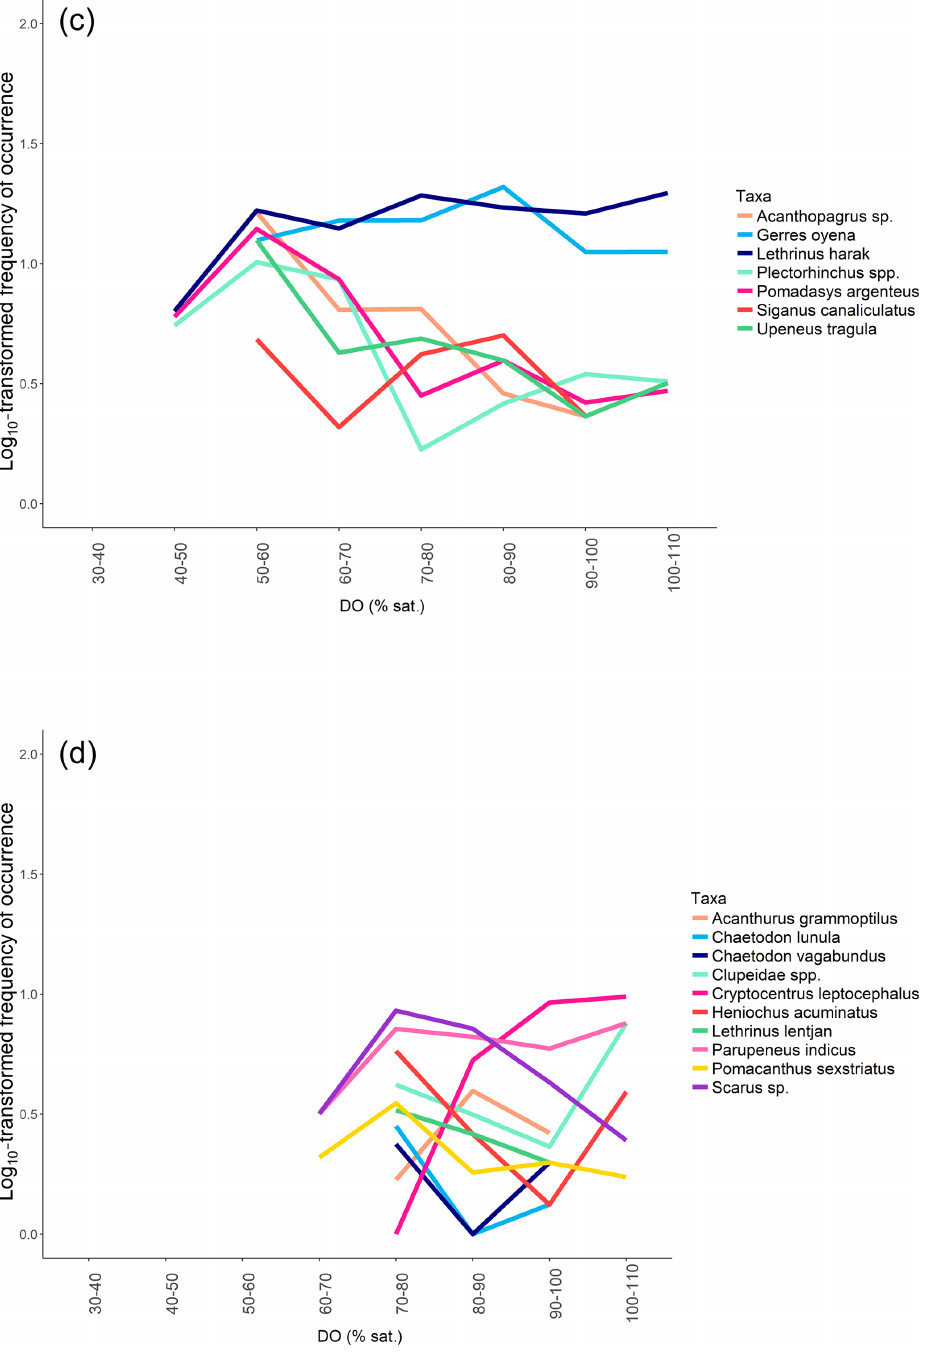
Figure A2. Species-specific patterns of mangrove utilisation grouped by type of patterns: (a) Pattern 1 – “High tolerance, (b) Pattern 1 – “High tolerance” (continued), (c) Pattern 2 – “Medium tolerance” – and (d) Pattern 3 – “Low